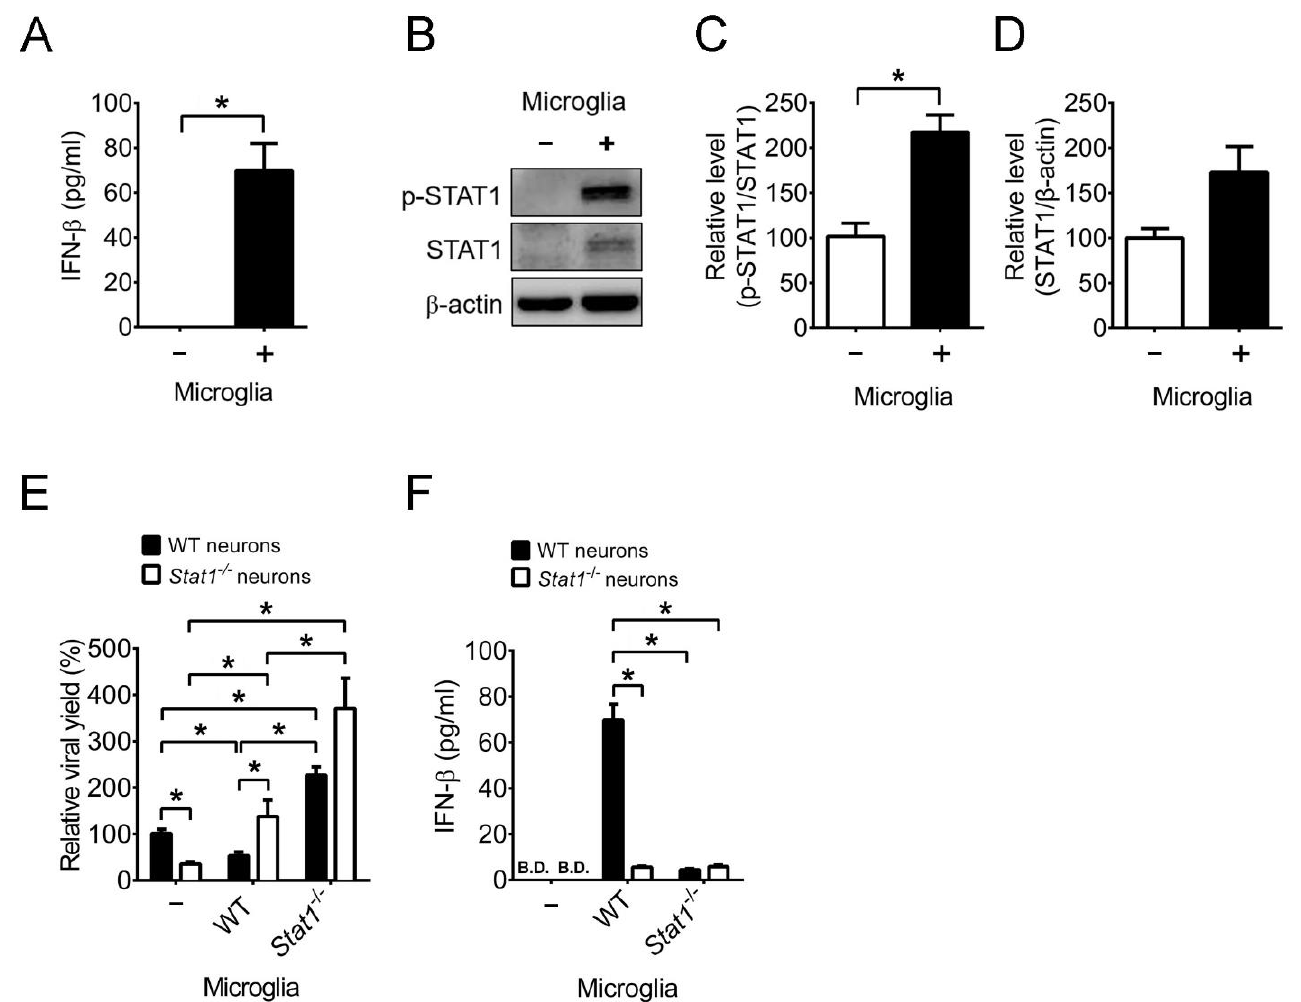
Figure 8. Microglia induce IFN- β and STAT1 phosphorylation to reduce the HSV -1 production in brain neurons. ( A ) Neurons (1 × 10 5 cells) were co-cultured without ( − ) or with (+) 1 × 10 5 microglia, infected with HSV-1 (MOI = 0.001), harvested 72 h post-infection, and assayed for IFN- β by ELISA. ( B – D ) Samples prepared as described in ( A ) were assayed for STAT1 by Western blotting. The relative levels of ( C ) Tyr701 phospho-STAT1 (p-STAT1)/STAT1 and ( D ) STAT1 normalized to β -actin are shown. Neurons (1 × 10 5 cells) from wild-type (WT) or Stat1 − / − mice were co-cultured without ( – ) or with 1 × 10 5 microglia from WT or Stat1 − / − mice, infected, and harvested as described in ( A ) for assays of ( E ) virus and ( F ) IFN- β. B.D., below the detection limit. The means of groups with WT neurons only were set as 100% ( C – E ). The data represent means + SEM (error bars) of 3 – 16 samples per group obtained from at least two independent experiments. *, p < 0.05.